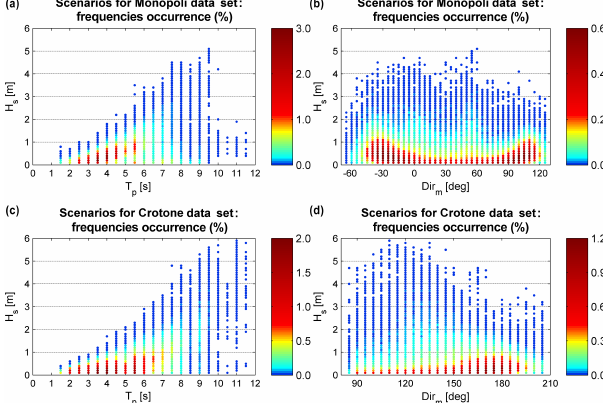
Figure 4. Frequencies of occurrence of the scenarios’ H s − T p and H s − Dir m pairs for the Monopoli data set ( a and b respectively) and the Crotone data set ( c and d